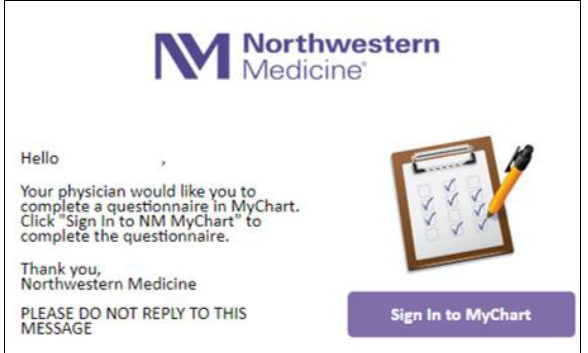
Figure 2. Patient e-mail notification for the tobacco screener questionnaire assignment. © 2020 Epic Systems Corporation. Used with permission.